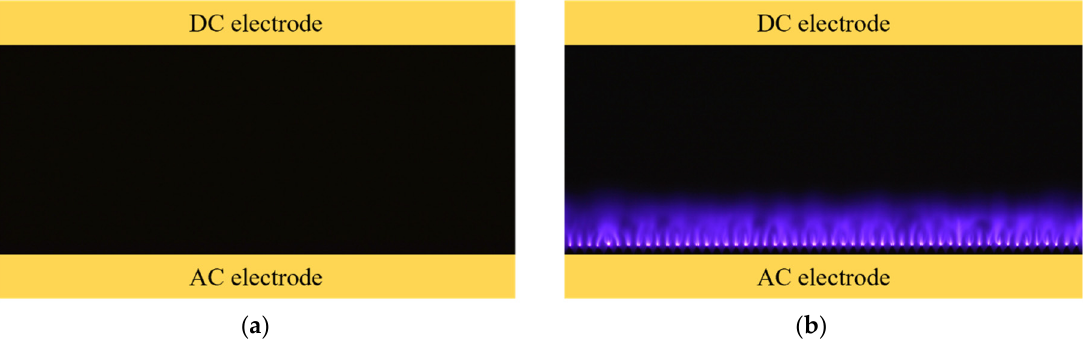
Figure 11. Discharge photographs in the case where a voltage of 10 kV pp at 4 kHz was applied to the AC electrode, and the DC electrode was grounded, in the ( a ) CD-PA and ( b ) TED-PA.